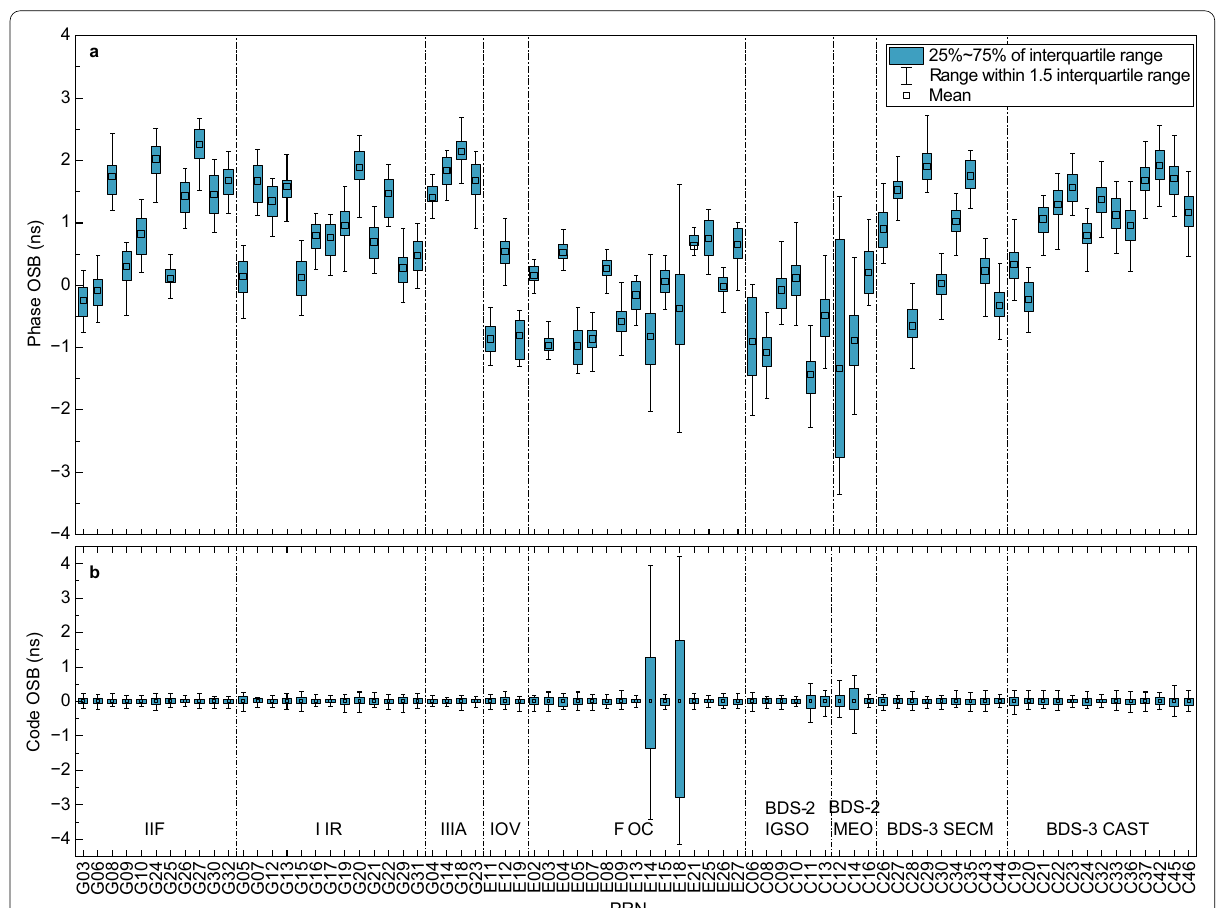
Fig. 2 Box chart of OSBs for multi-GNSS satellites. Pseudo-Random Noise (PRNs) of satellites are sorted by satellite types and are depicted in the bottom panel. a depicts phase OSBs for GPS L1W, Galileo L1C, and BDS L2I; b represents code OSBs for GPS C1W, Galileo C1C, and BDS C2I